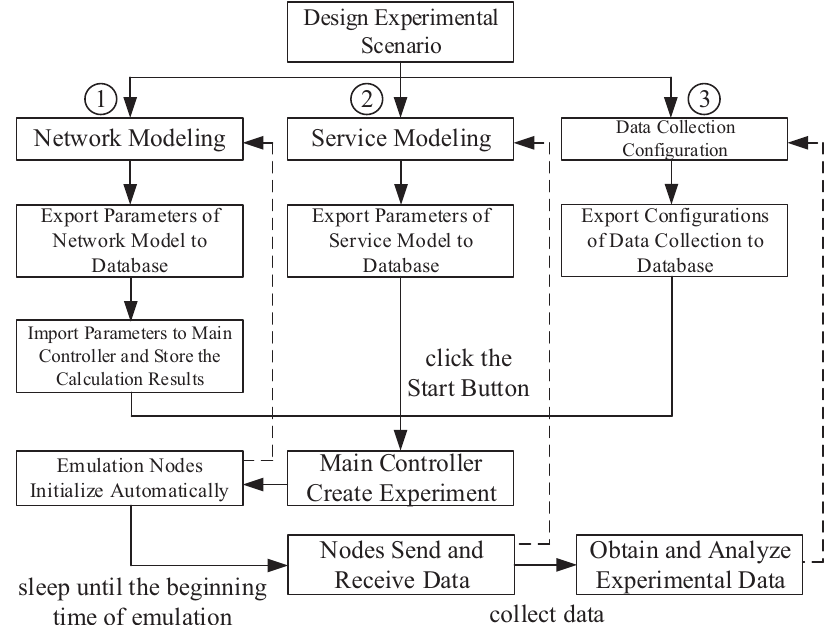
Figure 11. Experiment working